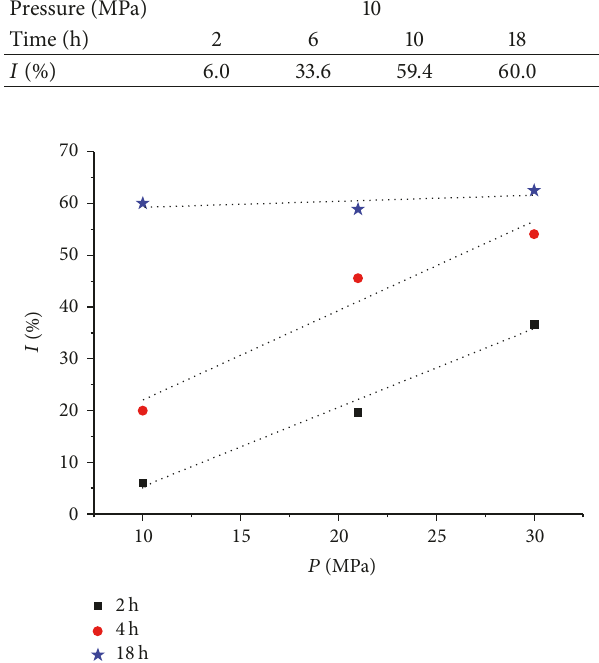
Figure3:Changeincarvacrolimpregnationyieldwithpressure(the lines are drawn to guide the eye).